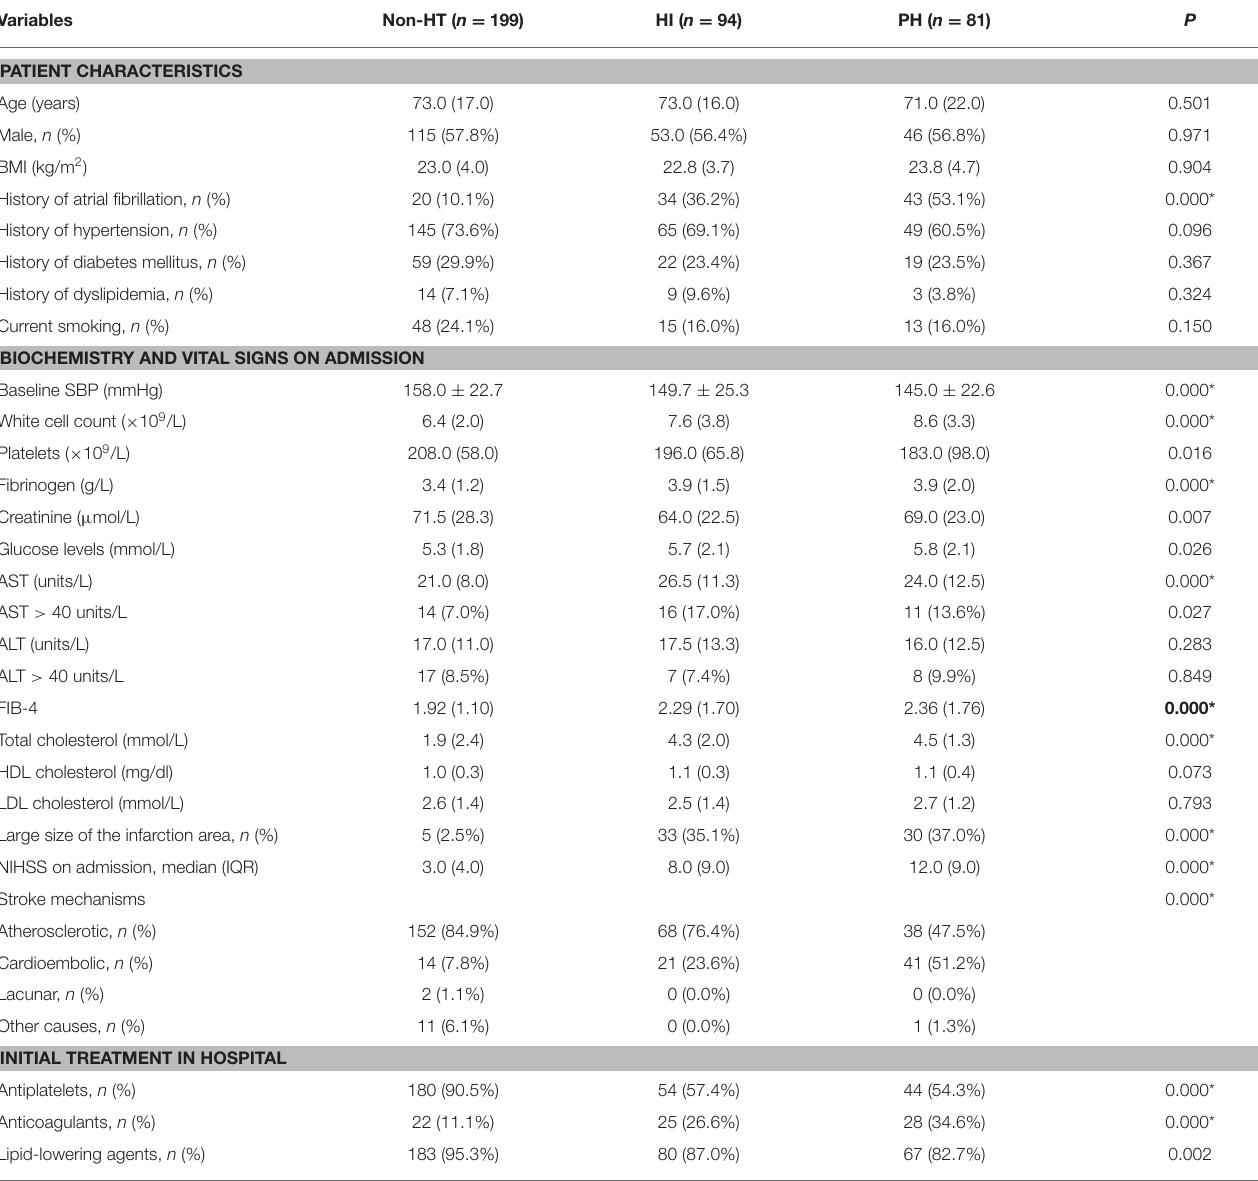
TABLE 3 | Baseline characteristics of the patients according to the subcategorized groups of HT.